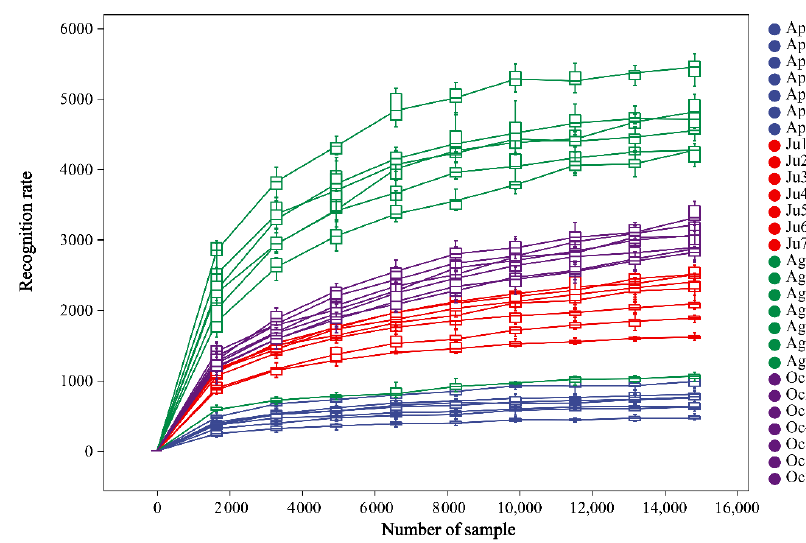
Figure 1. Rarefaction curves of sample